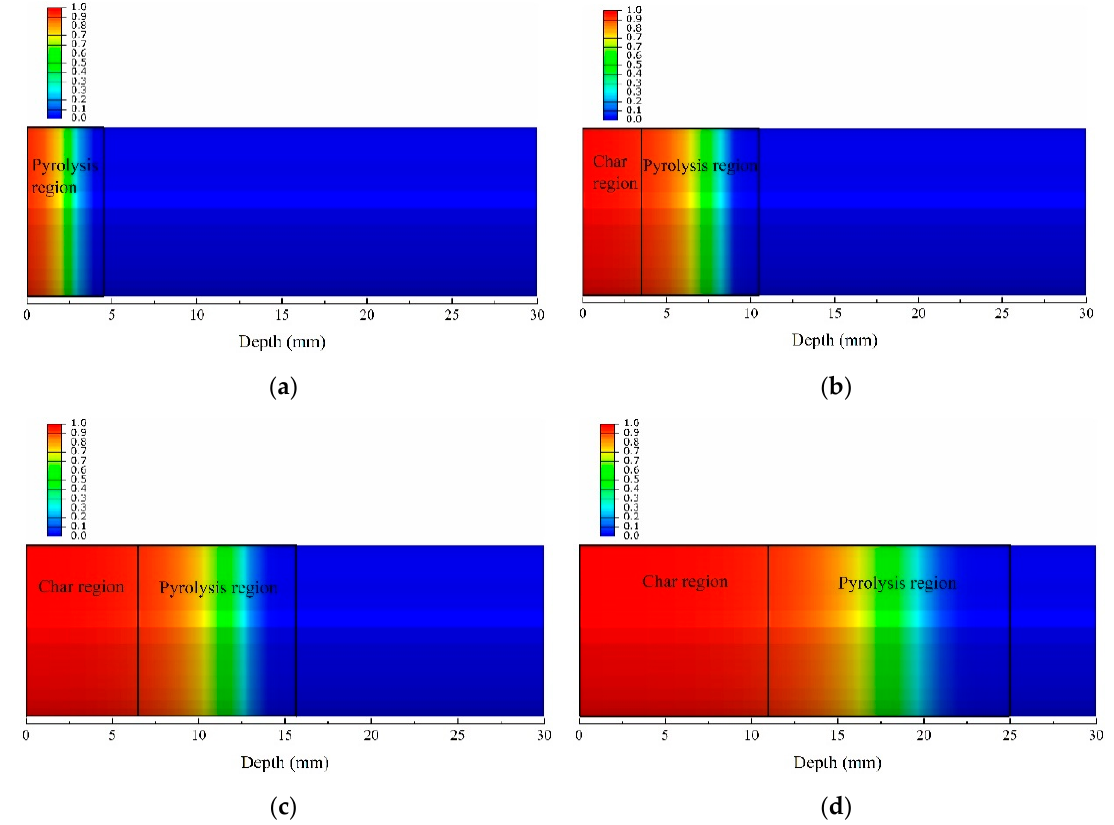
Figure 8. Decomposition degree contours of the glass fiber/phenolic resin composites at different times under one-sided heating. ( a ) 50 s; ( b ) 200 s; ( c ) 400 s; ( d ) 800 s.